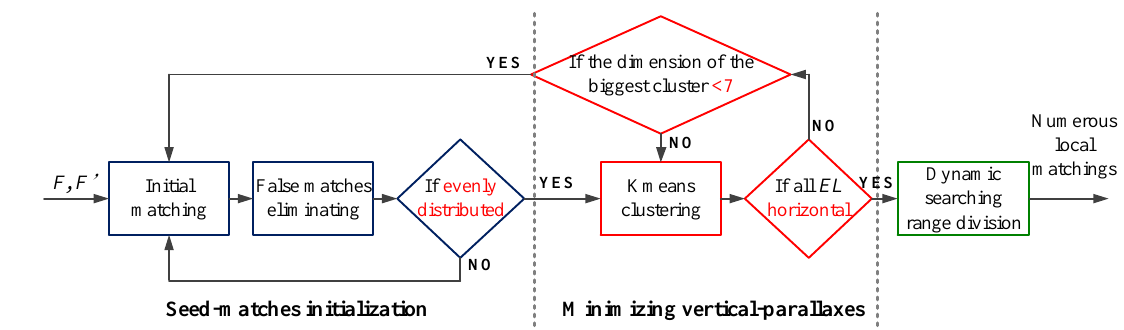
Figure 5. The flow chart of global matching splitting.